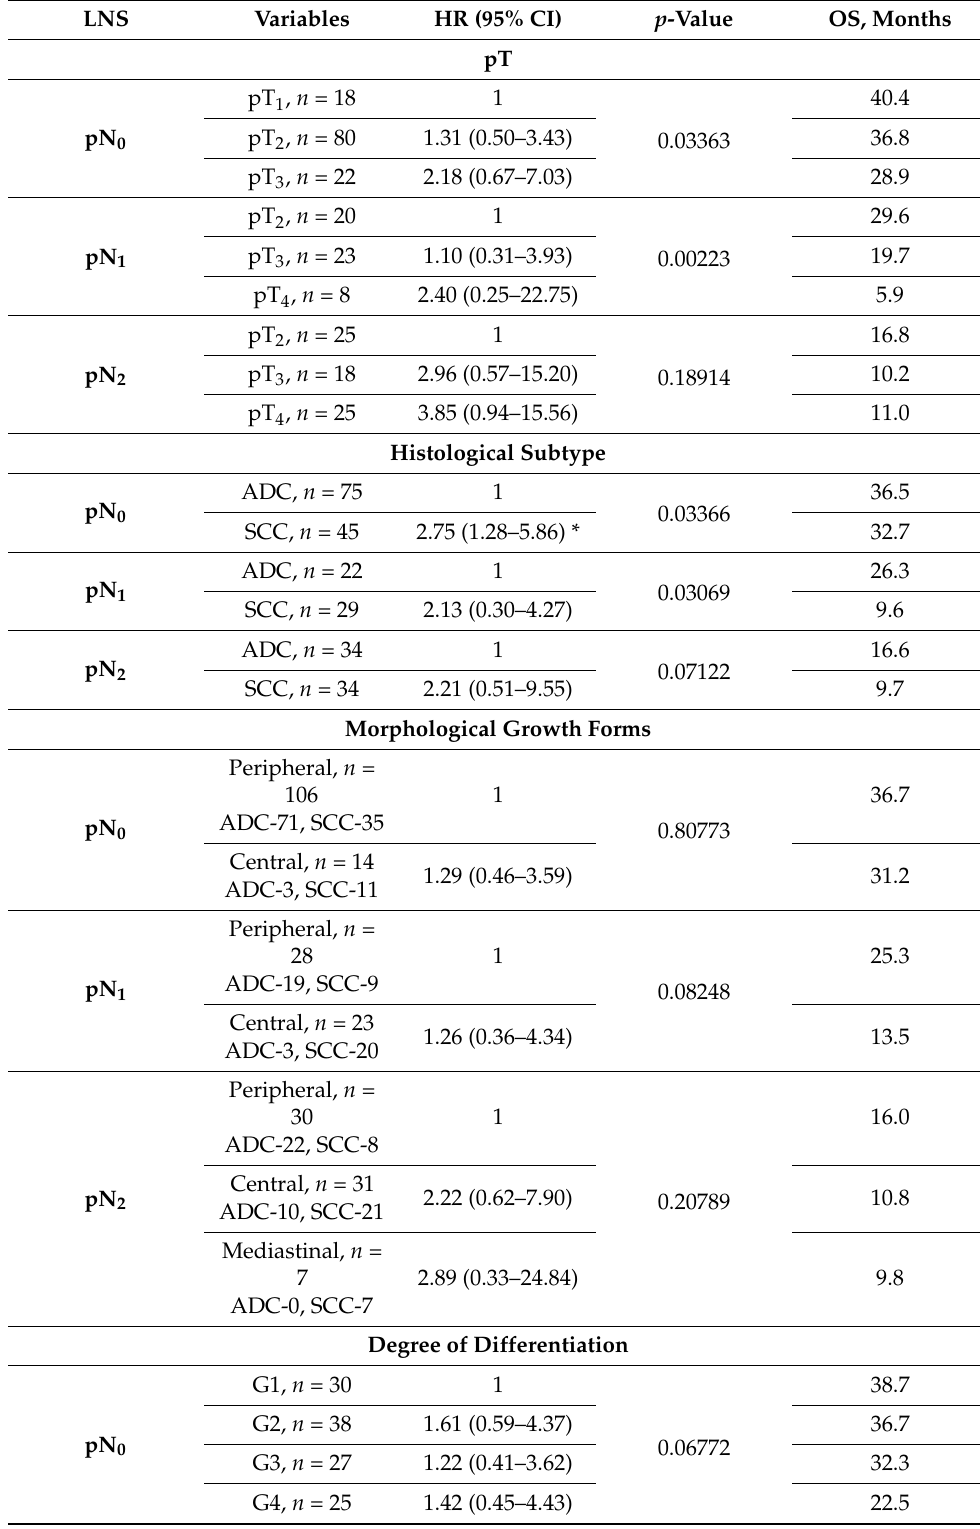
Table 1. Overall survival rates depending on tumor size, histological type, growth form, and degree of differentiation of lung